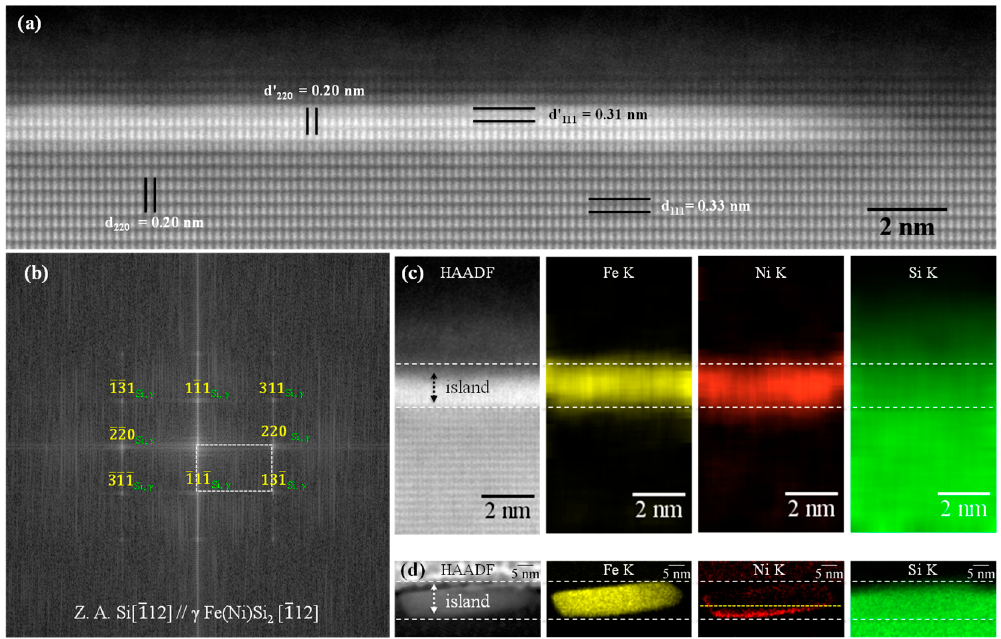
Figure 3. STEM analysis of typical γ -(Fe x Ni 1-x )Si 2 NSs: ( a ) cross-sectional HAADF micrograph, ( b ) corresponding Fourier power spectrum demonstrating [112] Si || [112] γ zone axis, and ( c ) HAADF and Fe-K, Ni-K, Si-K EDS maps. White broken lines in Figure 3c outline the top and bottom γ -(Fe x Ni 1-x )Si 2 NS boundaries. ( d ) HAADF STEM micrograph and corresponding EDS elemental mapping of a representative β -Fe(Ni)Si 2 phase NS given here for comparison, where white broken lines outline the top and bottom NS boundaries, and a yellow broken line roughly indicates the top boundary of the Ni-containing region close to the β -Fe(Ni)Si 2 /Si(111) interface.